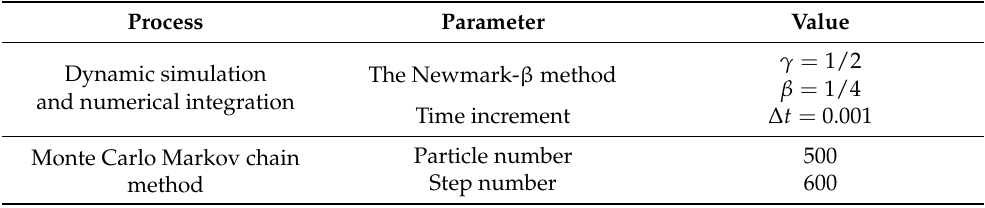
Table 6. The parameters of the PRE method with MCMC